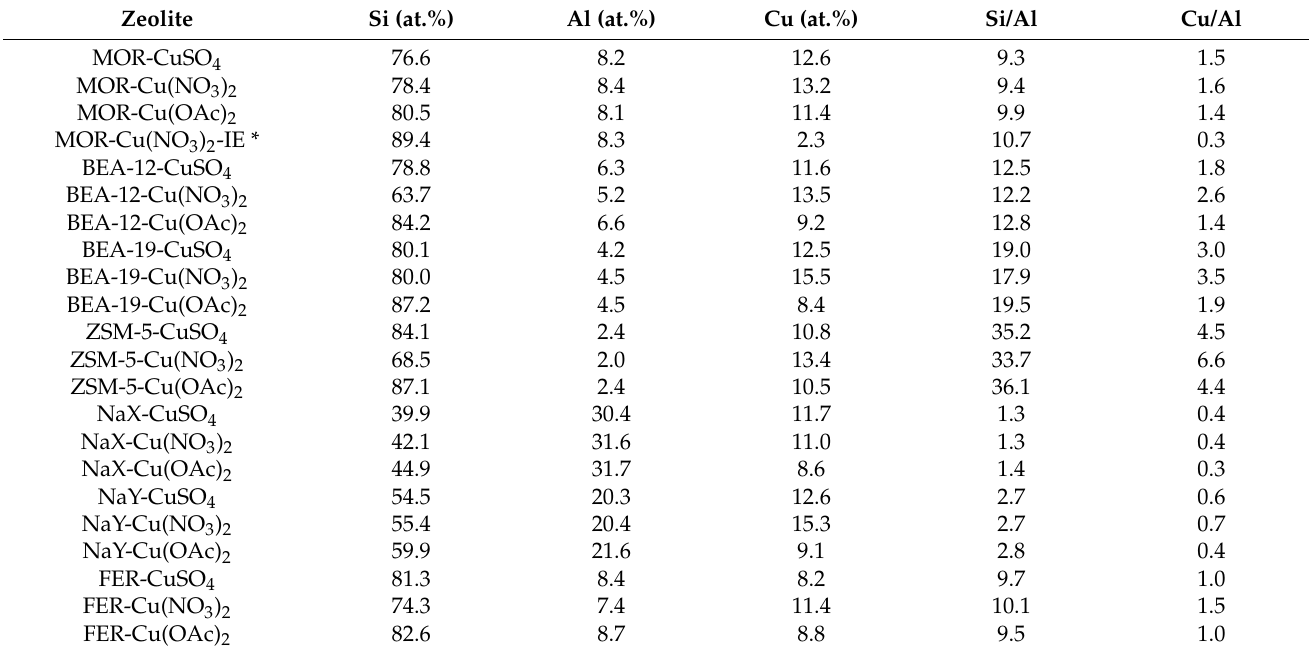
Table 1. EDX characterisation data of Cu-impregnated samples (* ion-exchanged sample). Zeolite Si